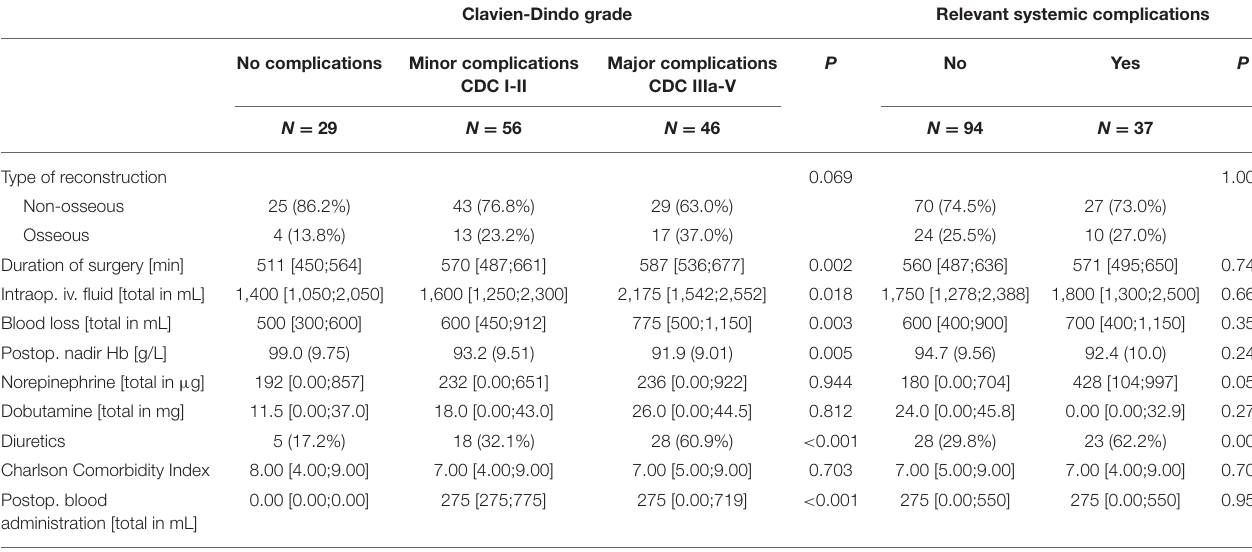
TABLE 2 | Intraoperative and postoperative variables.